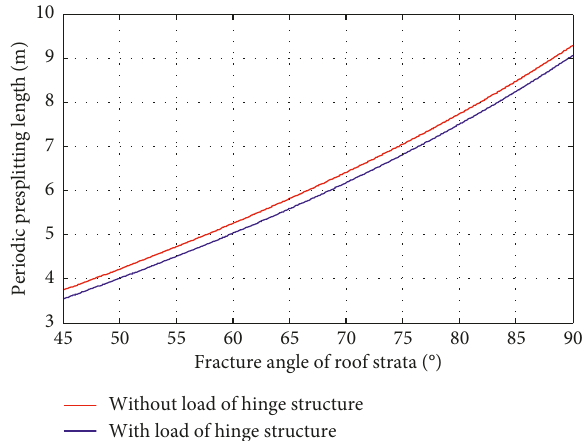
Figure 7: Relationship between the presplitting angle and periodic caving intervals.